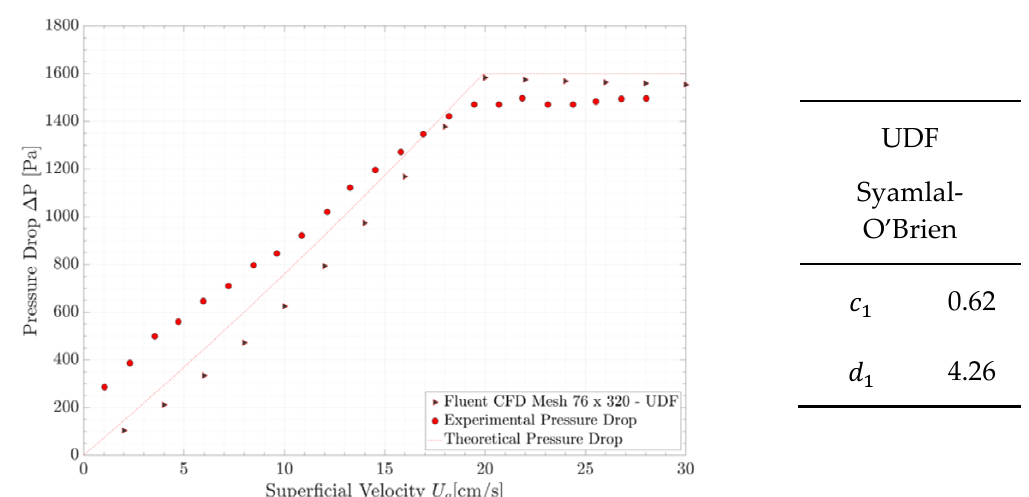
Figure 4. Pressure drop through the bed as function of the superficial gas velocity: comparison between theoretical pressure drop (red dashed line), experimental (red dot), and CFD calculation (black triangle). CFD calculations were obtained by implementing the parametric model of Syamlal-O’Brien: parameters of this model, are shown in the table.